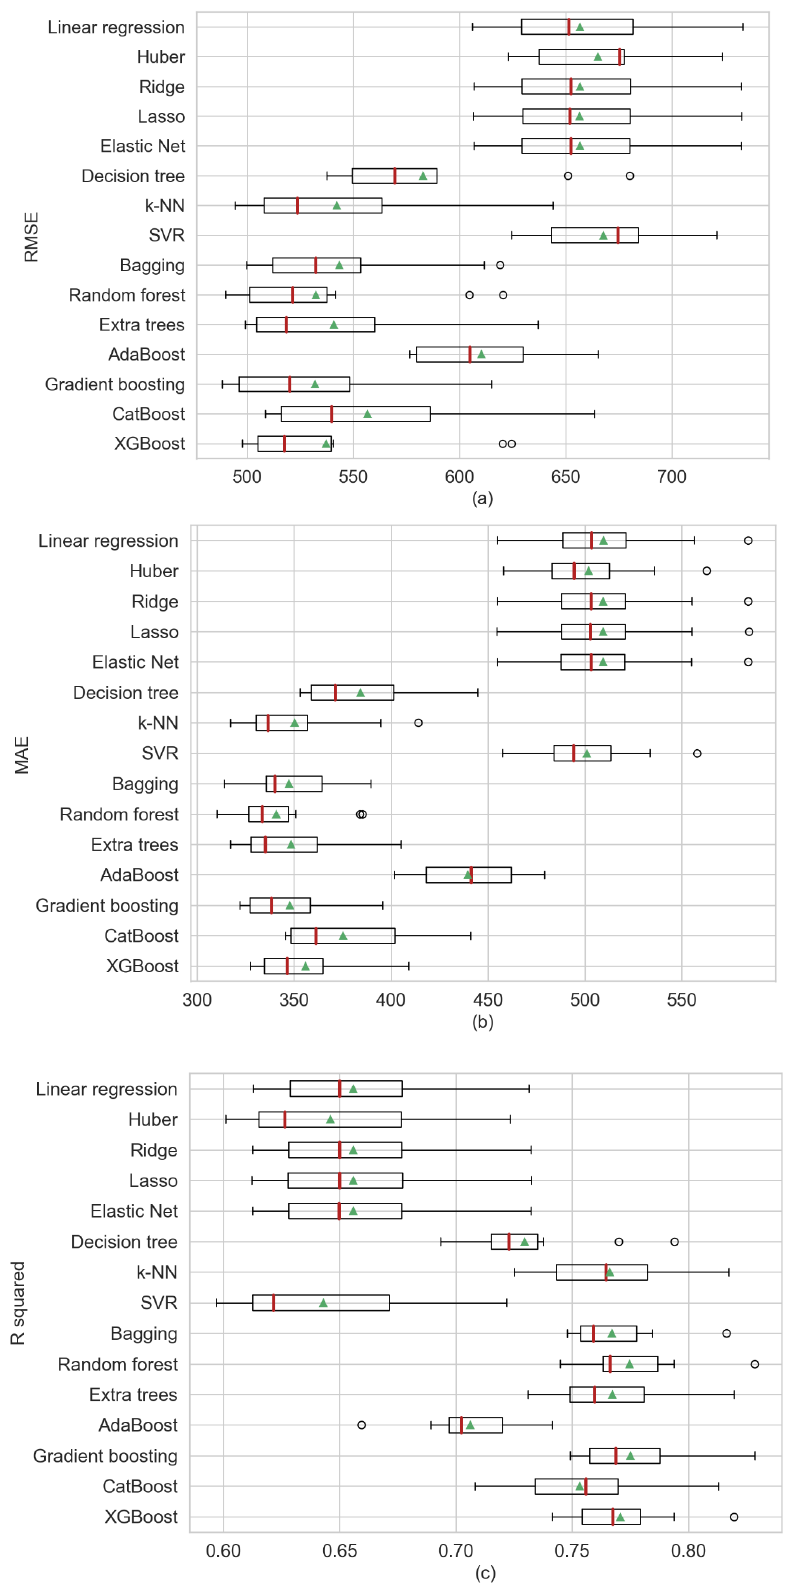
Figure 5. Comparative algorithm analysis using 10-fold cross-validation over forecast weather data analyzing ( a ) RMSE, ( b ) MAE, ( c ) R 2 as scoring metric. Finally, the third analysis presents the results of using observation and forecast weather data, as shown in Table 7. For the single regression models, k-NN gained the best scores—similar to when using forecast weather data. The k-NN model yielded better performances in RMSE, MAE and R 2 based on their mean (RMSE = 547.79, MAE = 358.28 and R 2 = 76.0%). Among the ensemble models,